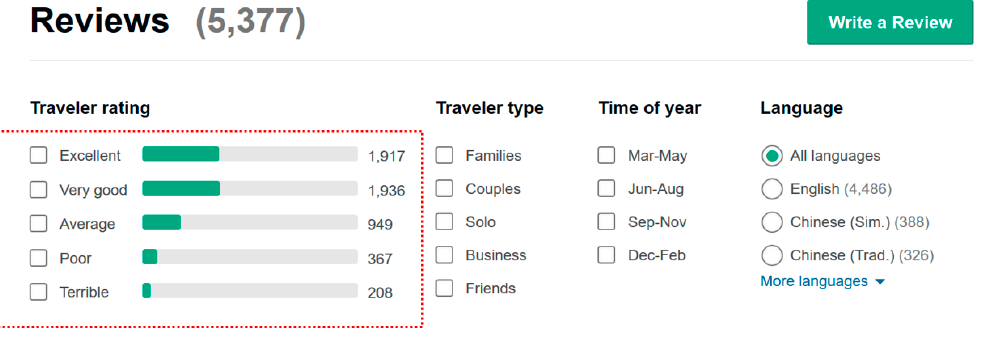
Figure 3. Five ratings on TripAdvisor.